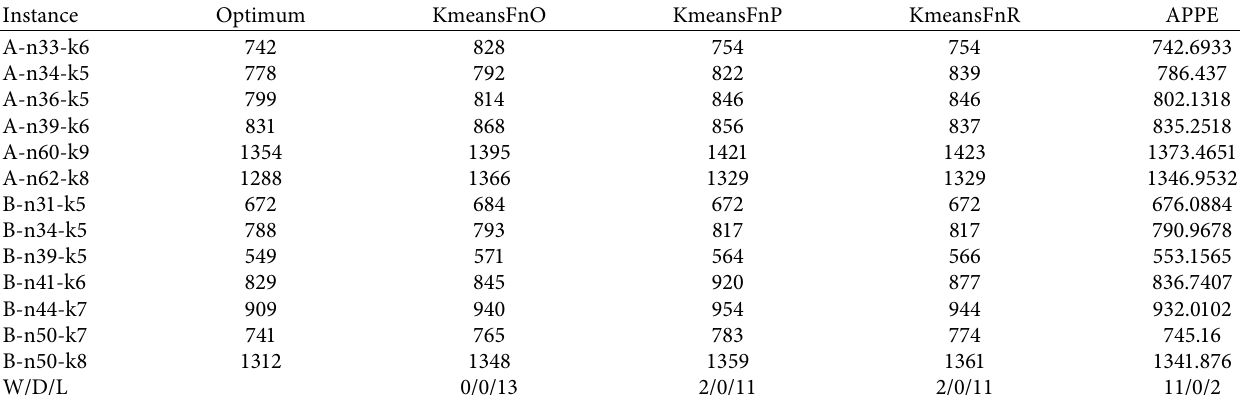
Table 16: Comparison of the best result of 10 runs of APPE with the algorithms proposed by Korayem et al.